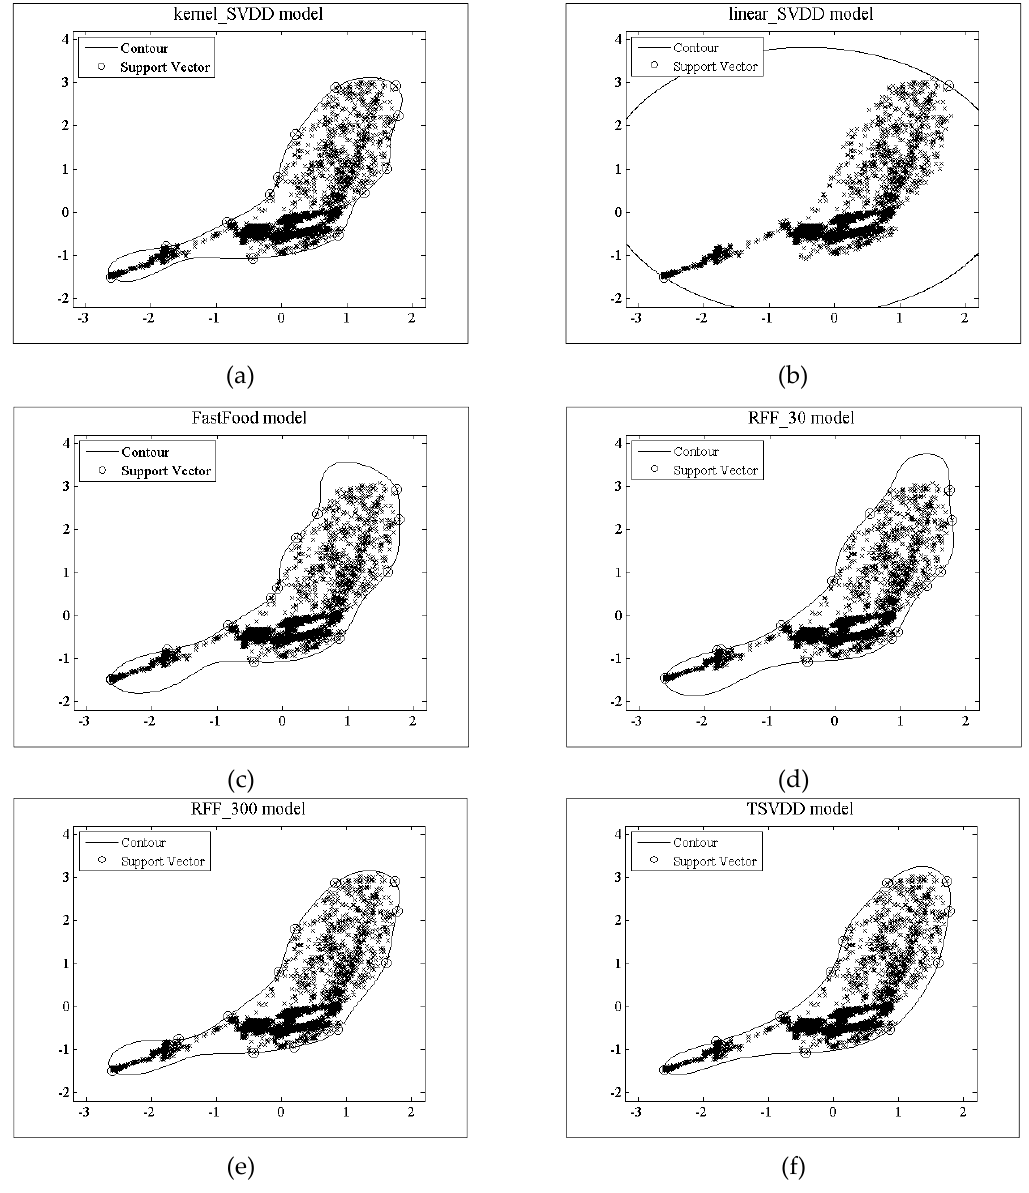
Figure 5. Decision models trained by different algorithm on SS_12-3 dataset ( a ) kernel_SVDD model; ( b ) linear_SVDD model; ( c ) FastFood model; ( d ) RFF_30 model; ( e ) RFF_300 model; ( f ) TSVDD model